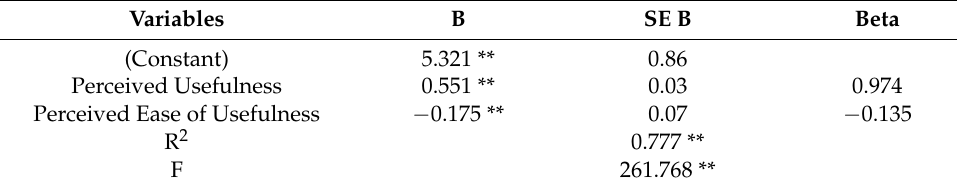
Table 5. Predictors of